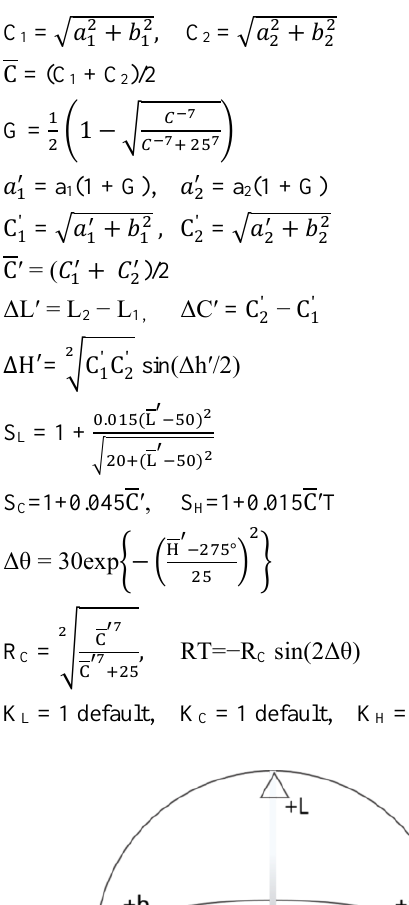
Figure 10. Interaction plot for Δ E*00 Table 7. ANOVA for Δ